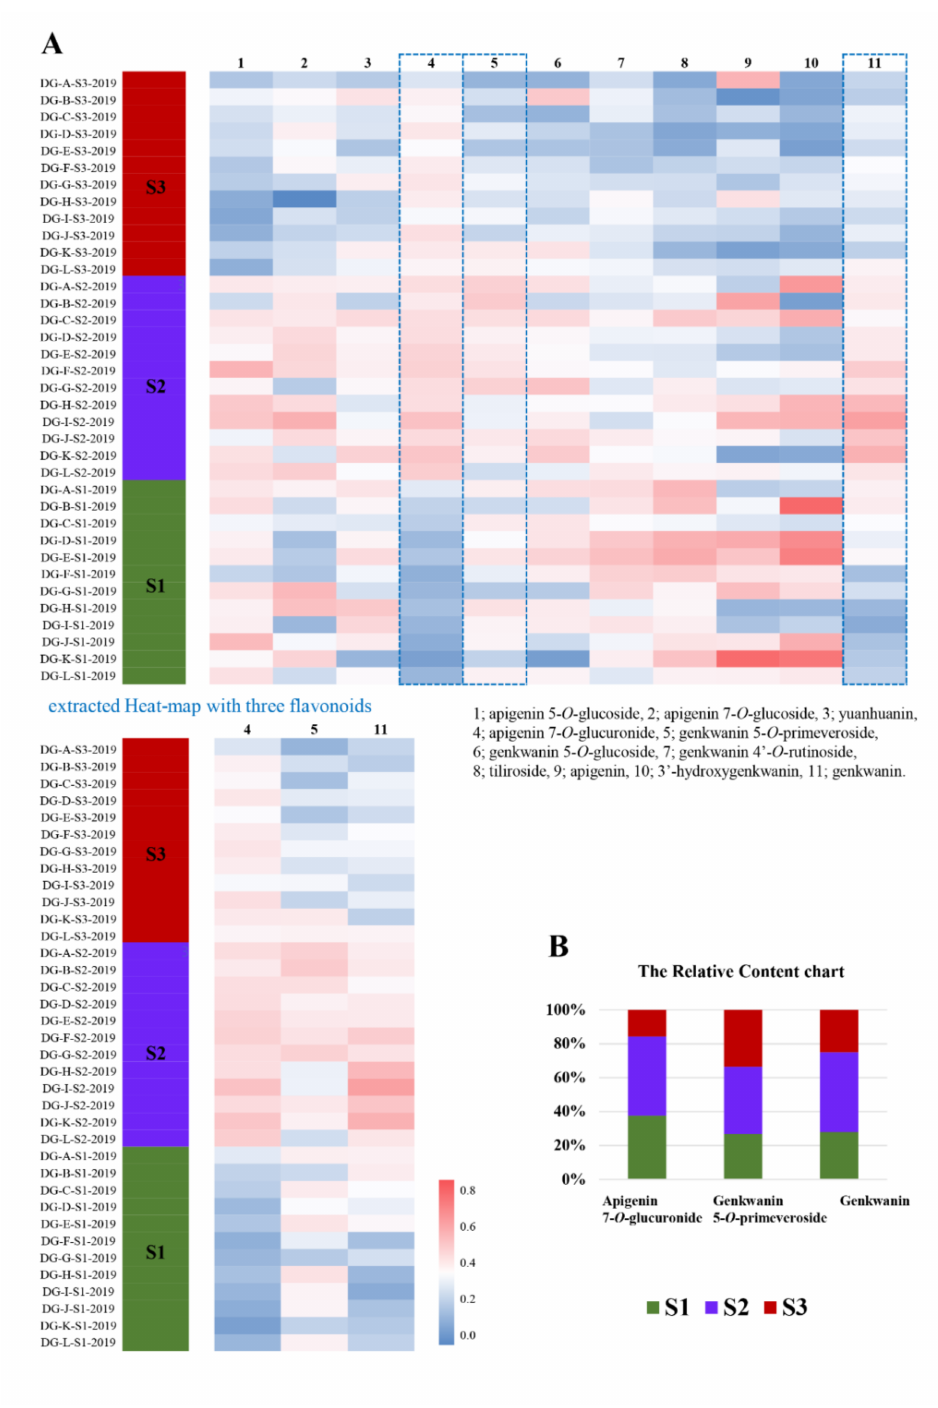
Figure 7. Significant changes in flavonoid biomarker candidates in S1, S2, and S3 blooming stages: ( A ) Heat-map visualization for 11 flavonoids and three significant flavonoids and ( B ) the relative content chart for three